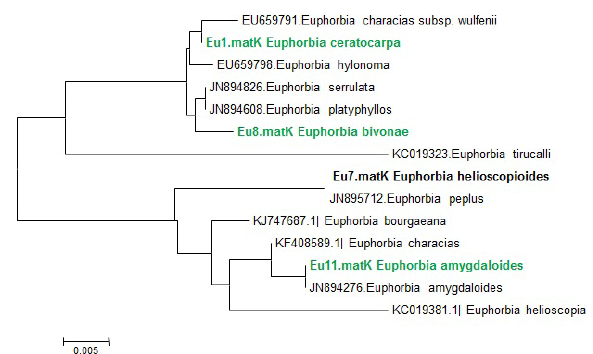
Fig. 5. Phylogenetic tree of Euphorbiaceae family with Neighbor Joining for mat K.